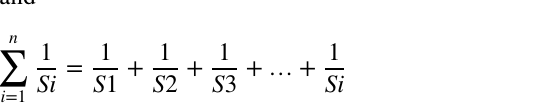
Table 2 Limits and weight of heavy metals used for WQI calculation Source : Vetrimurugan et al. (2017) Heavy